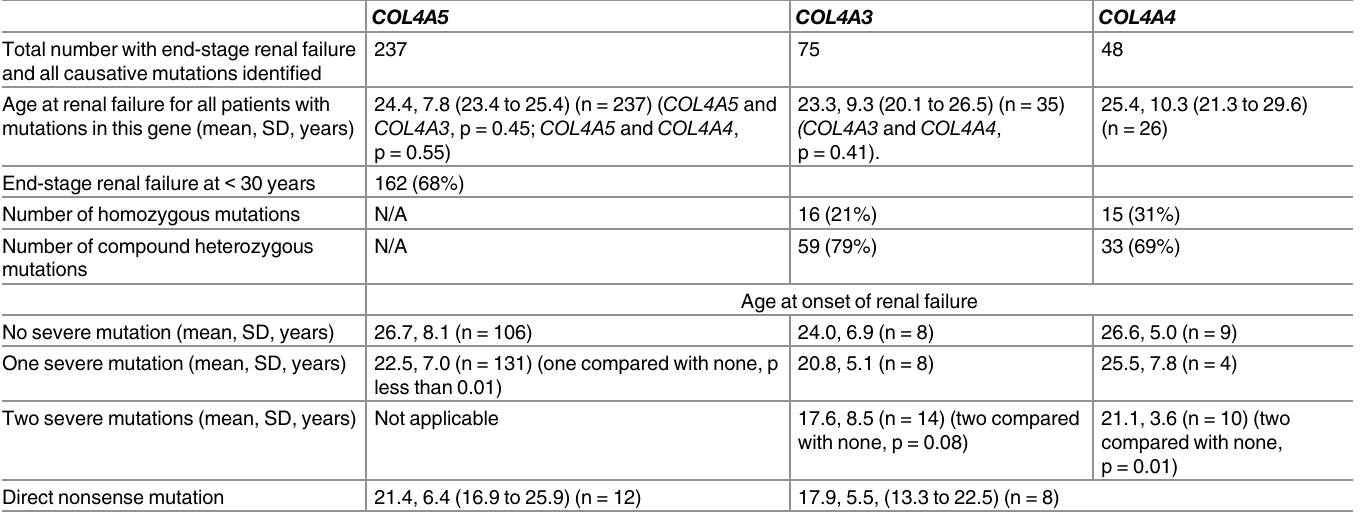
Table 5. Age at end-stage renal failure and severity of mutations with COL4A5 , COL4A3 and COL4A4